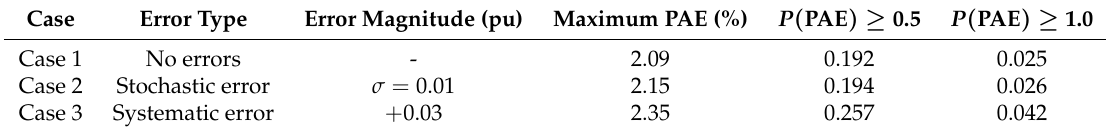
Table 3. Performance of DSSE with measurement errors for the year 2018 data.